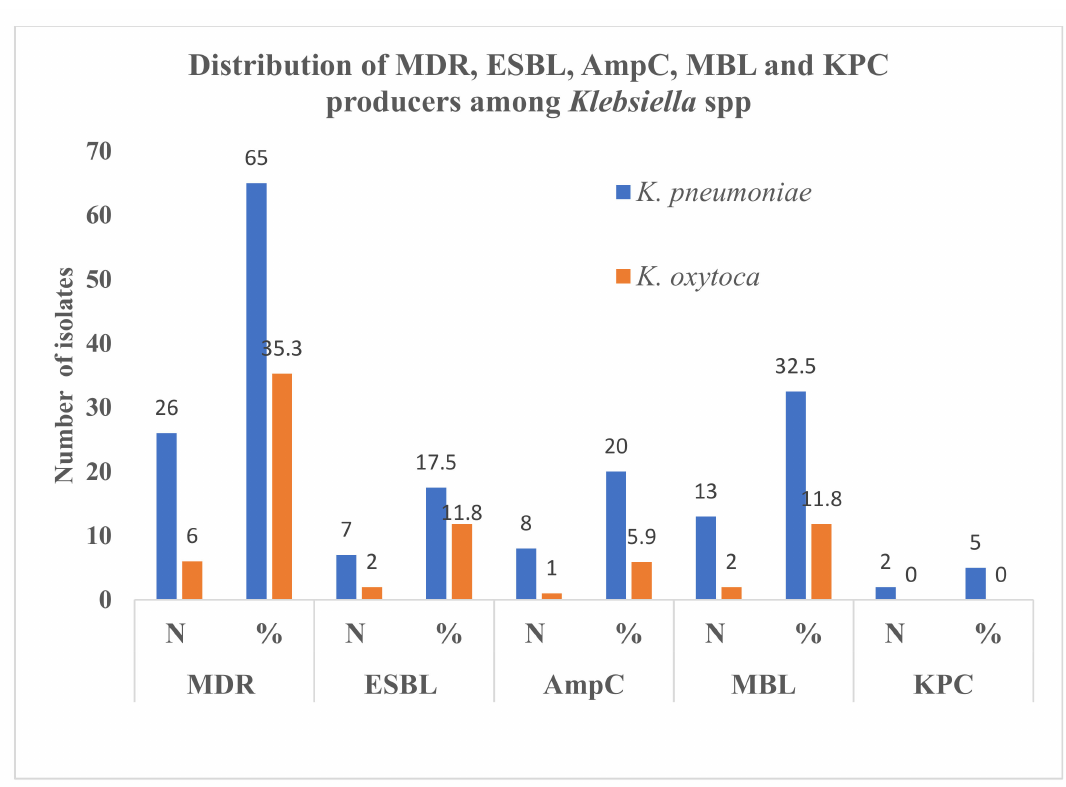
Figure 3. Distribution of MDR, ESBL, AmpC, MBL and KPC producers among Klebsiella isolates ( n =